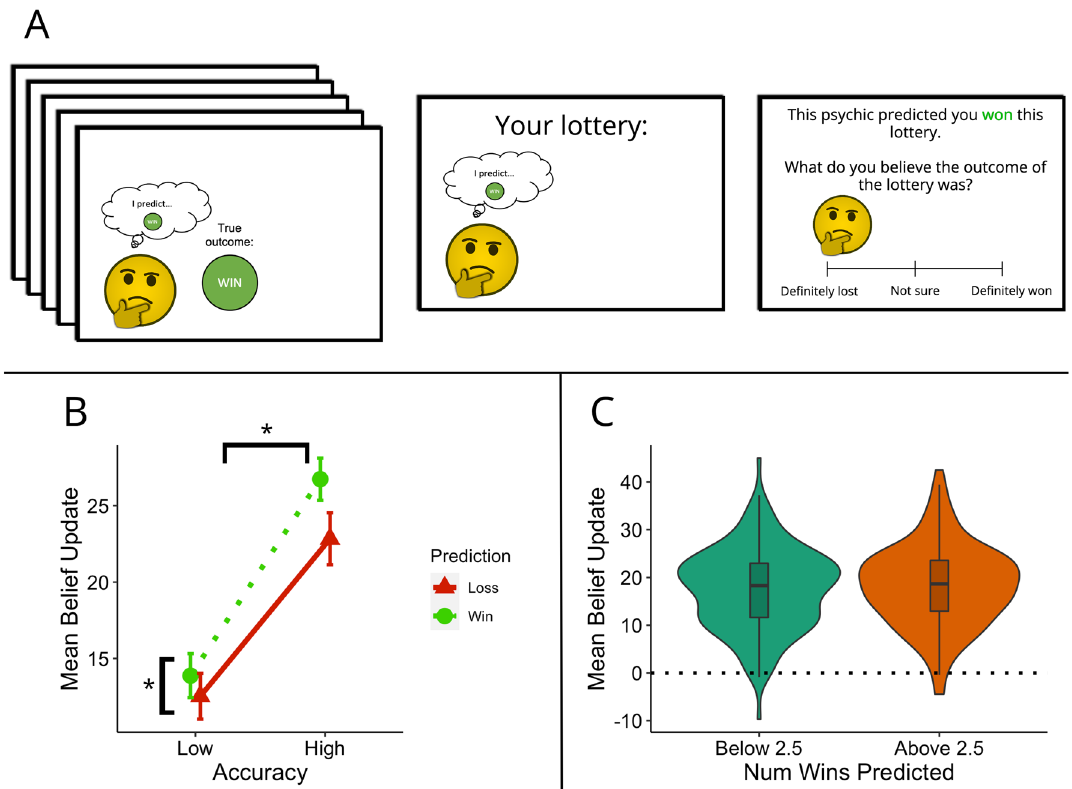
Figure 3. ( A ) Paradigm for Experiment 2. On each trial, participants were first shown a series of five example predictions made by the psychic. The true outcome of each of these lotteries was also shown. The psychic then provided a prediction of the participant’s own lottery, for which the true outcome was not shown. Participants were then asked to rate their beliefs about the outcome of their lottery on a continuous scale. ( B ) Mean magnitude of belief update following positive and negative predictions made by psychics with high and low accuracy. Error bars denote the standard error of the mean. Greater belief updates were made following predictions from more accurate psychics. Participants also updated their beliefs more in response to positive predictions than negative ones. Asterisks denote significant main effects of accuracy (high/low) and prediction (win/loss). ( C ) Distribution of mean belief updates following predictions from psychics with below or above the average number of positive example predictions.